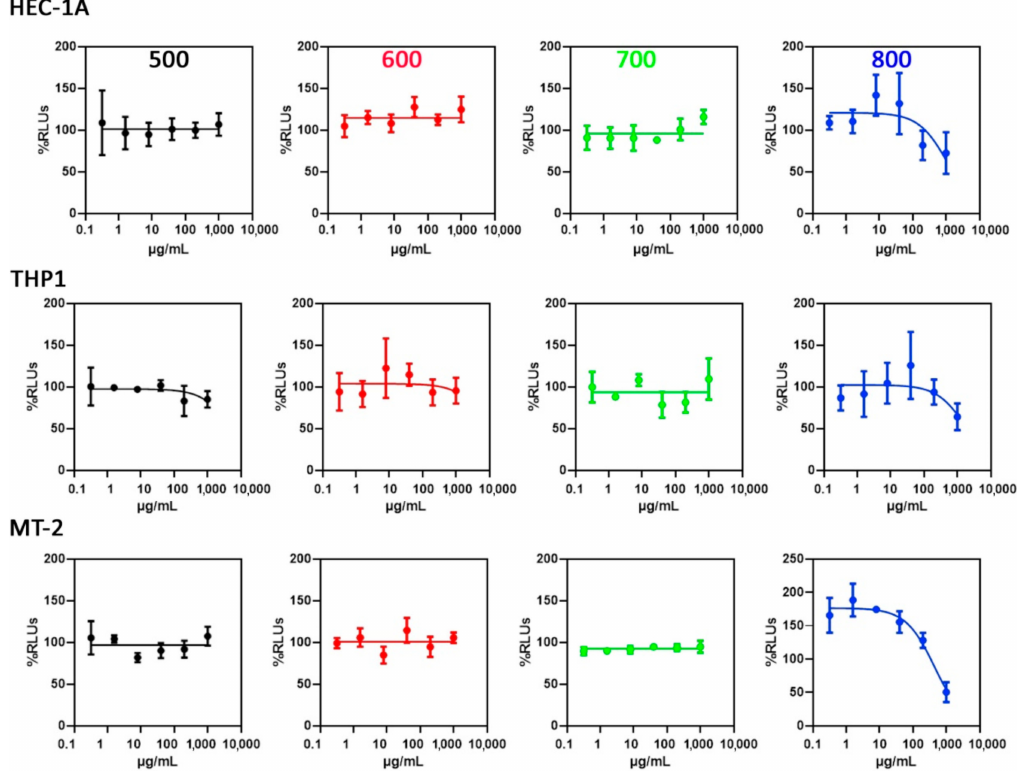
Figure 4. Graphic representation of the cytotoxic evaluation of the particles pyrolyzed at 500, 600, 700 and 800 ◦ C in MT-2, THP-1 and HEC1A cells. Cell viability is expressed as percentage of living cells (%RLUs) as compared to a non-treated control (100%). RLUs: Relative luminescence